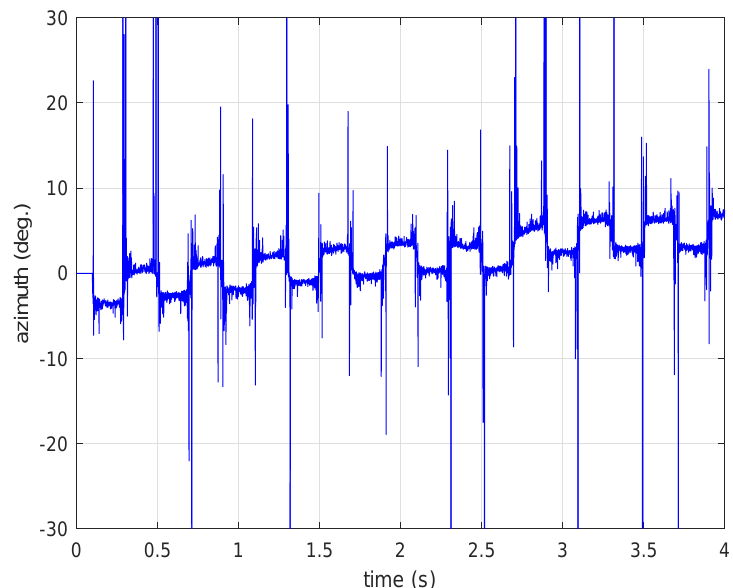
Figure 23. The azimuth error signal from the monopulse receiver when a sinusoidal amplitude modulation is applied to the blink jamming signal.